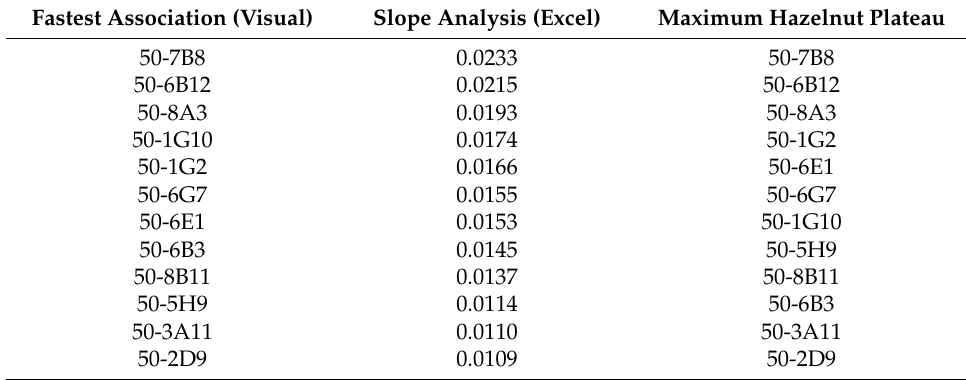
Table 1. Antibody ranking based on the visually observed association rates towards hazelnut, the confirmation by slope analysis in Excel and the amount of hazelnut bound (according to RU values observed in